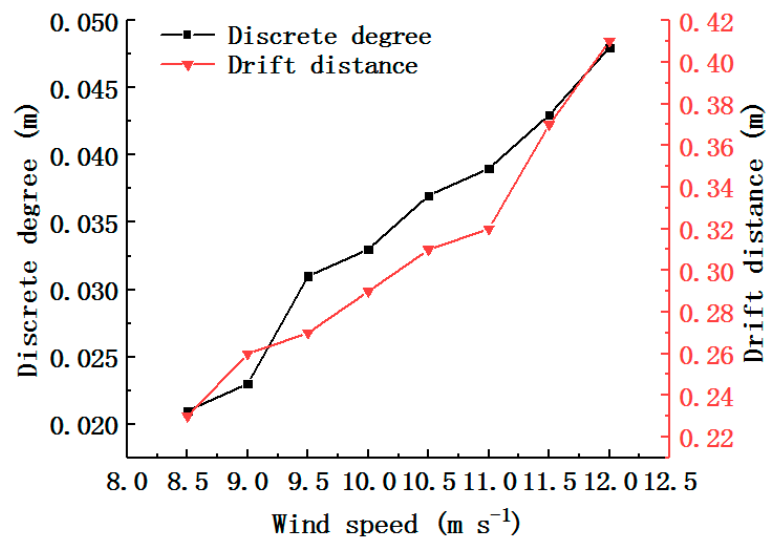
Figure 15. Experimental results for different wind speeds.